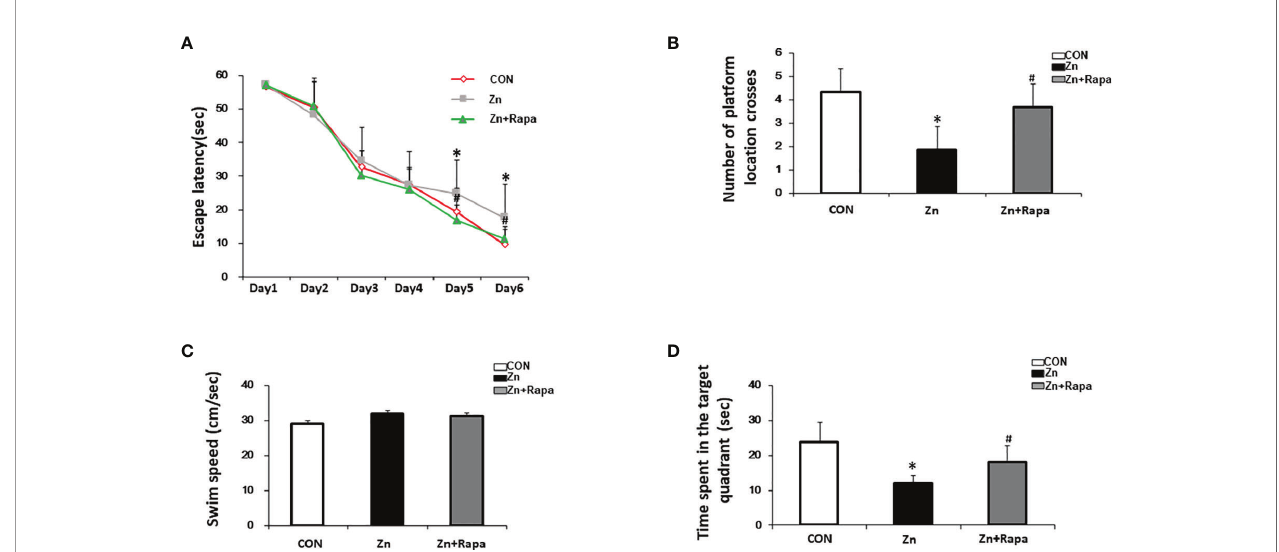
FIGURE 6 | The effect of rapamycin on the performance of the Morris water maze (MWM) in zinc-induced rats. (A) Escape latency of the rats in all three groups [control (red), zinc-injected (gray), zinc+rapamycin treatment (green)] in the MWM test of each training day. (B) Representative number of platform crossings on day 7. (C) Representative time spent in the target quadrant on day 7. (D) Swimming speed in the MWM on day 7. n = 6 rats per group, *p < 0.05 vs. control group; #p < 0.05 vs. rapamycin